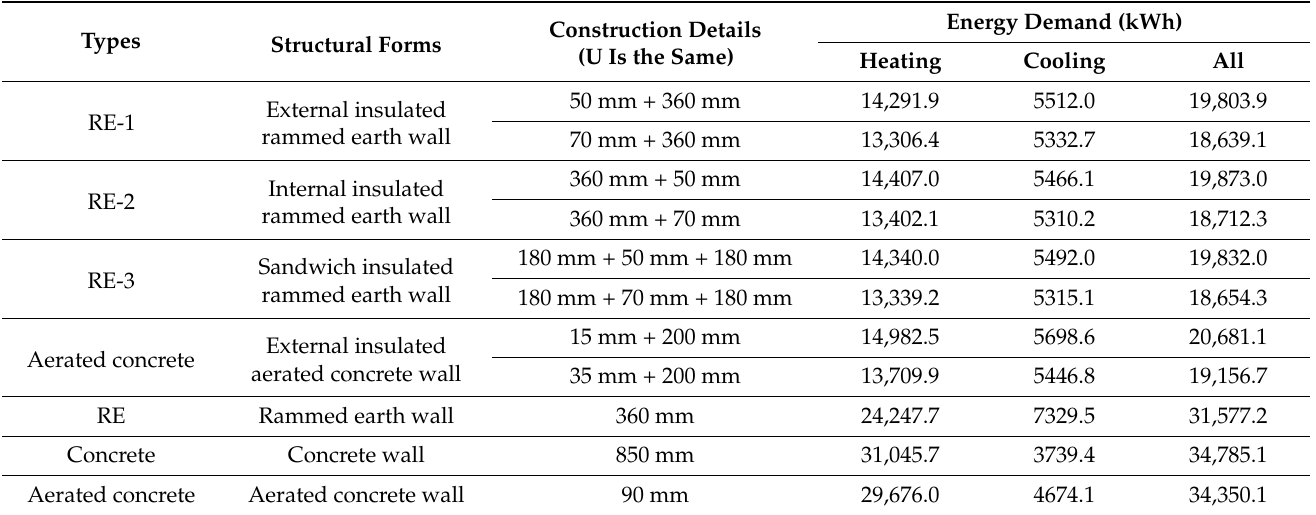
Table 9. Energy Demands of Different